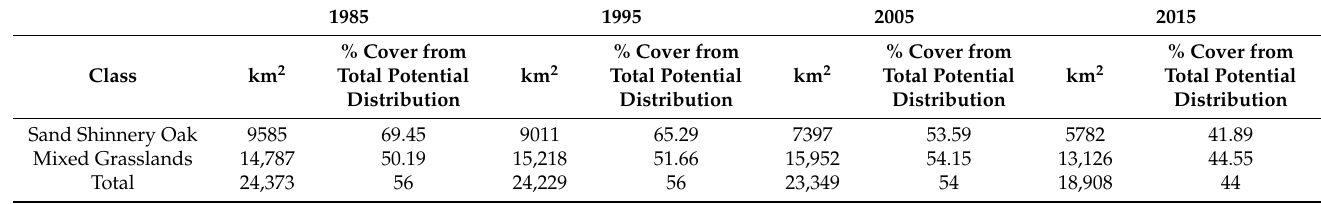
Figure 5. Location of the shinnery oak-dominated land (dark green) and mixed grasslands (light green) and anthropogenic (grey) land-cover distributions from Landsat-based image classification for 1985, 1995, 2005, and 2015. Table 2. Summary statistics for the 1985–2015 Landsat-based assessment to map vegetation com- munities that support lesser prairie-chicken populations on the New Mexico and Texas Southern High